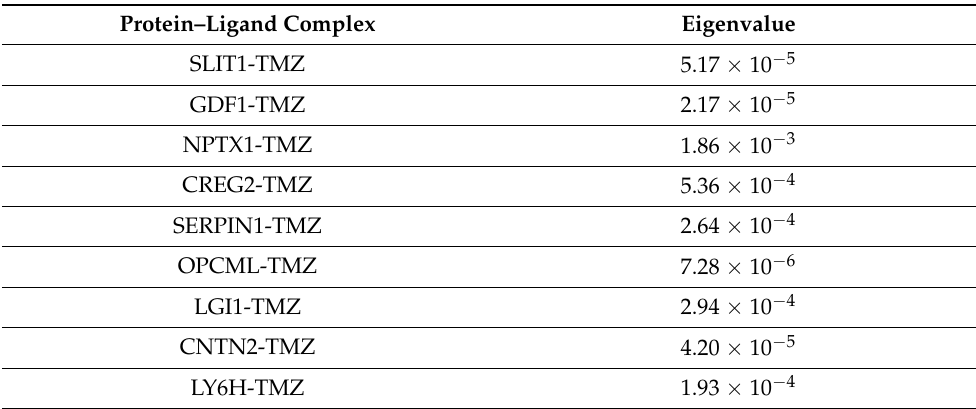
represented by green-shaded bars. The eigenvalue for each complex is provided in Table 2, whereas the eigenvalue and variance graphs of NPTX1-TMZ, CREG2-TMZ, SERPINI1-TMZ, OPCML-TMZ, LGI1-TMZ, CNTN2-TMZ and LY6H-TMZ are provided in Supplementary Materials Figures S1–S7, respectively. Table 2. Eigenvalues of the Docked Proteins Calculated by iMODS. Protein–Ligand Complex